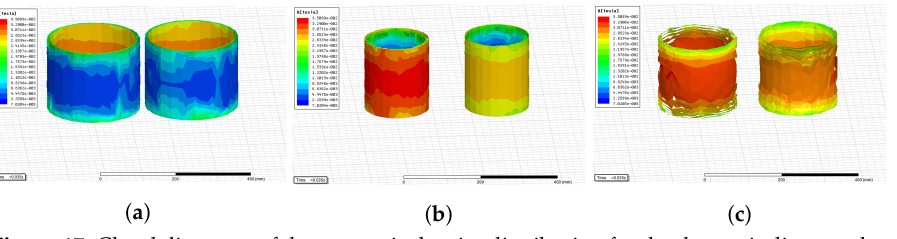
Figure 17. Cloud diagrams of the magnetic density distribution for the three windings under working condition 2. ( a ) Grid-side windings. ( b ) Valve-side windings. ( c ) Filter-side windings.